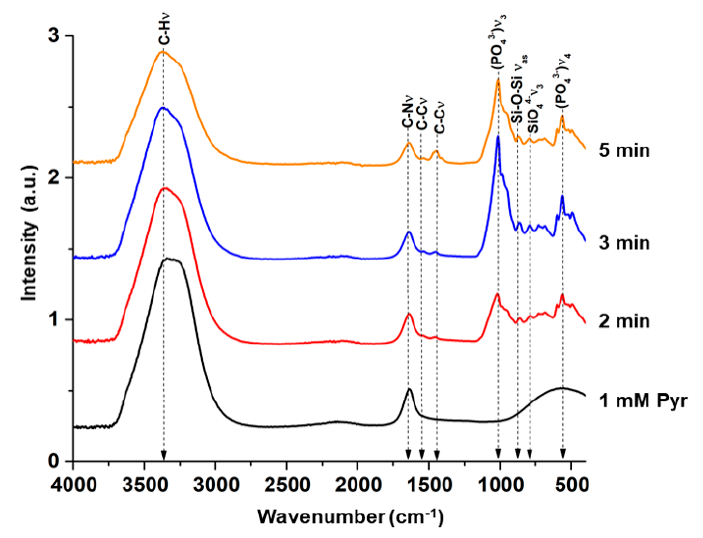
Figure 11. Infrared spectra of 1 nM pyridine on the supports doped for 2, 3 and 5 min in a 20 mM AgNO 3 solution at 3.3 V, and of 1 mM pyridine (black).